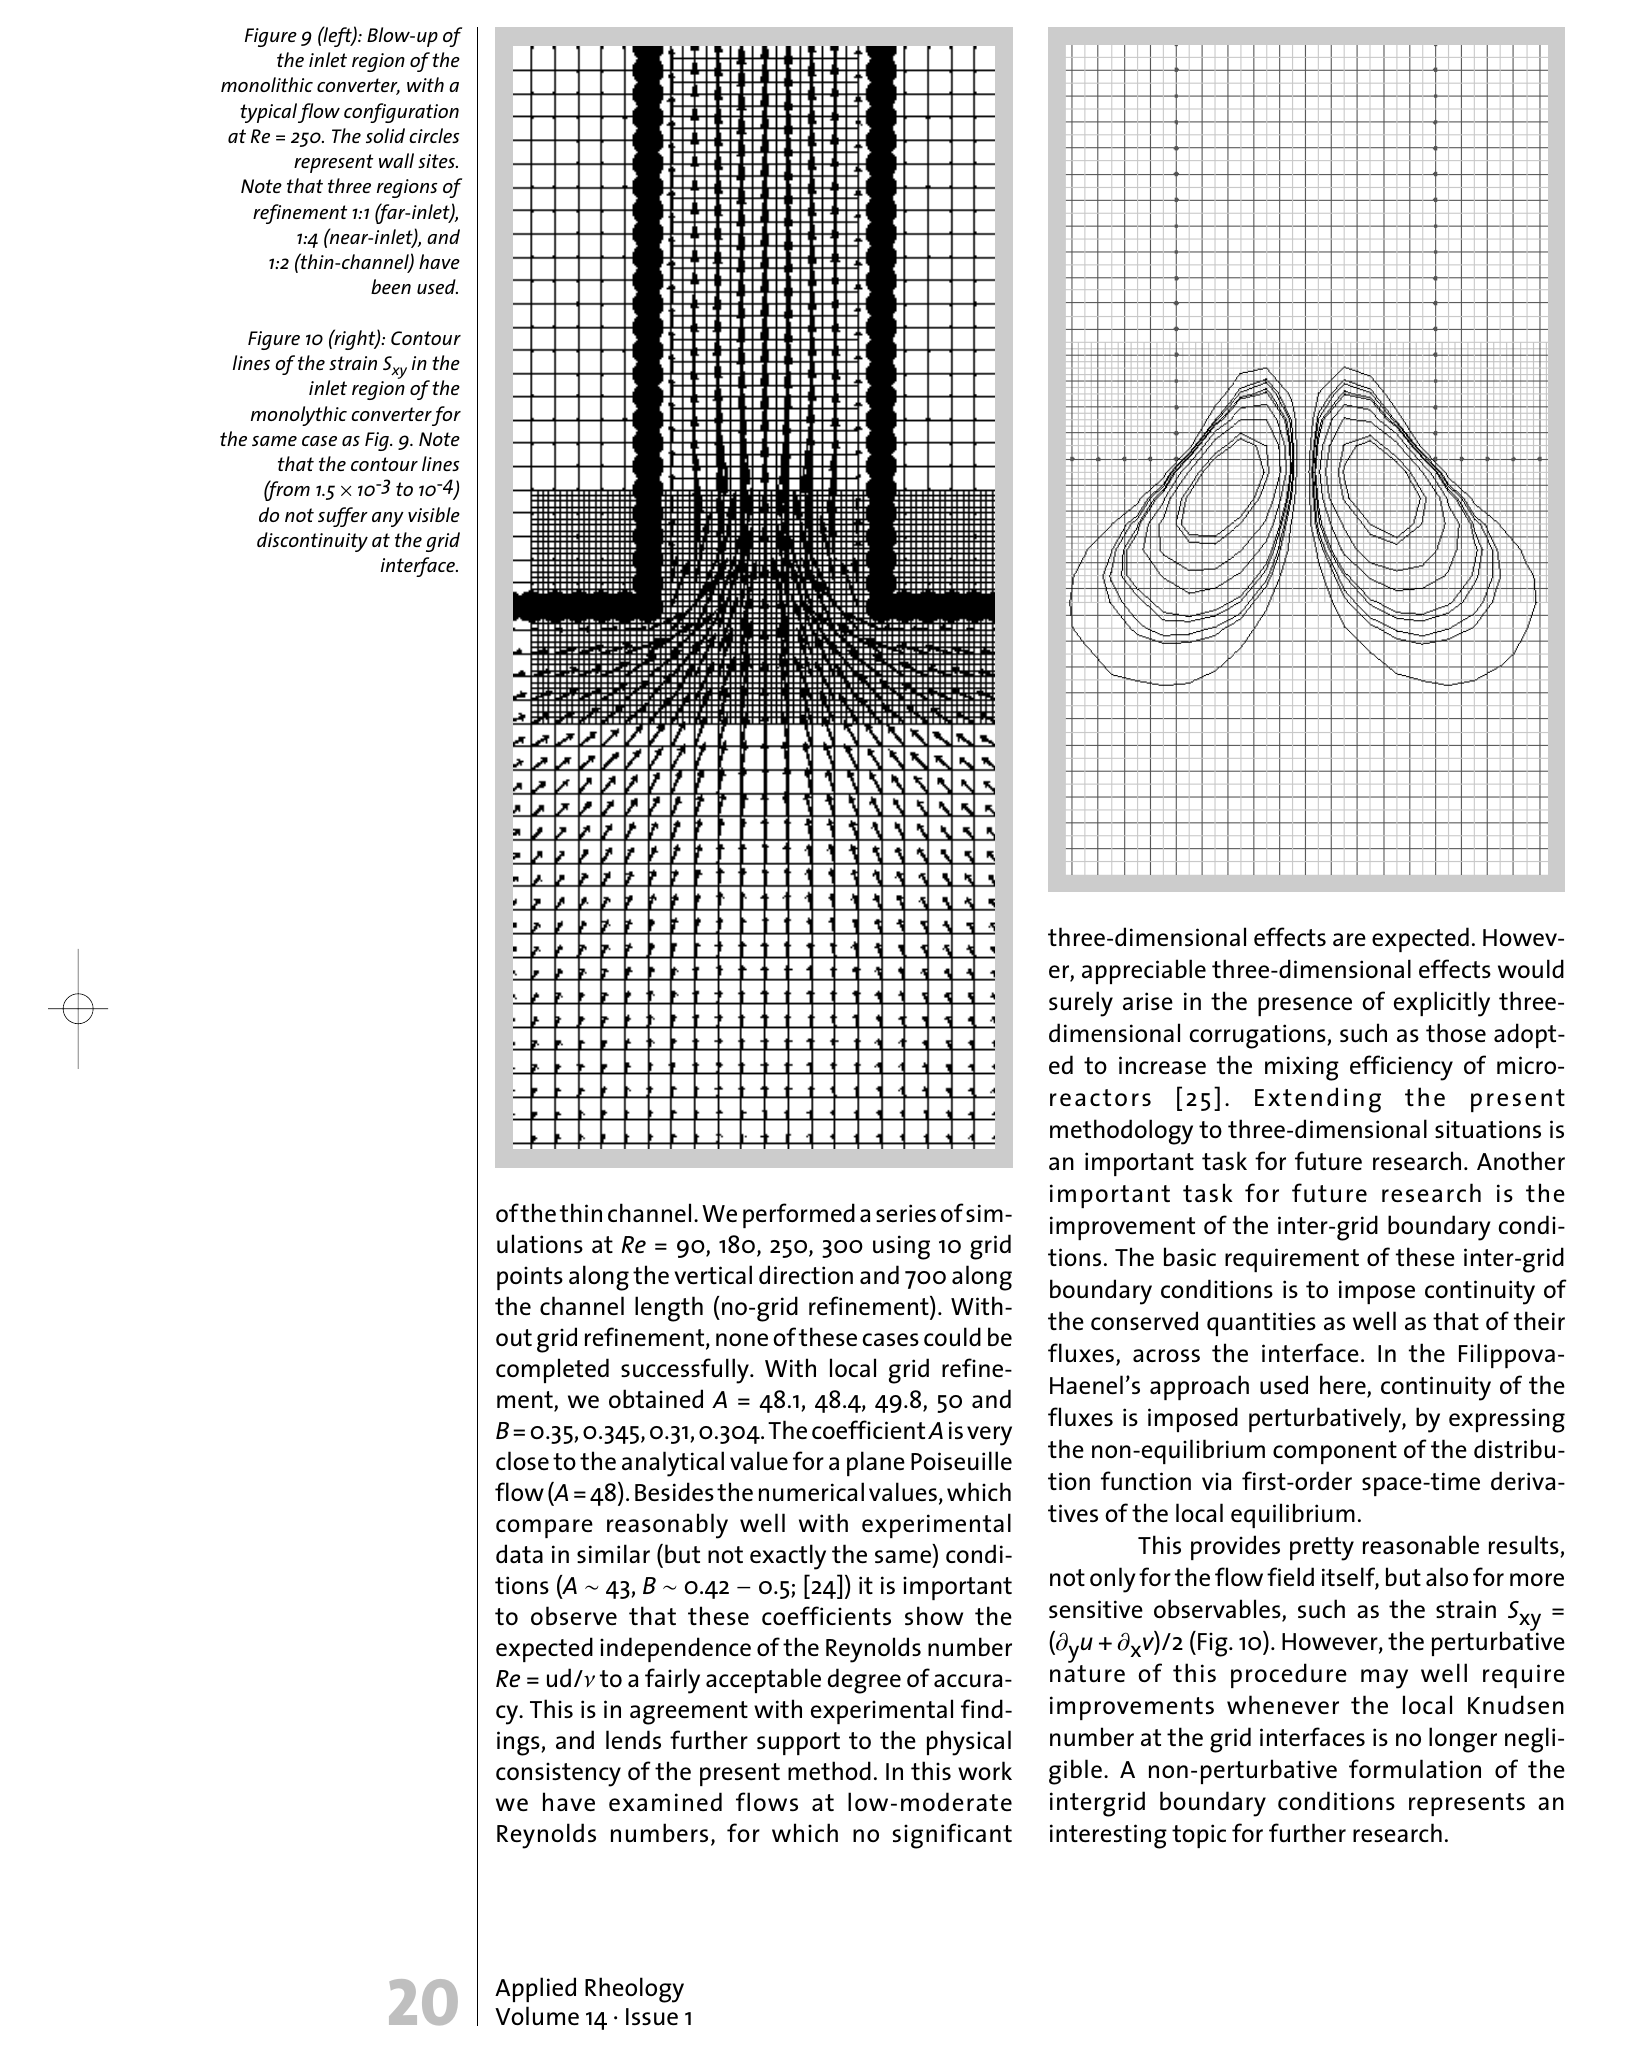
Figure 9 (left): Blow-up of the inlet region of the monolithic converter, with a typical flow configuration at Re = 250. The solid circles represent wall sites.